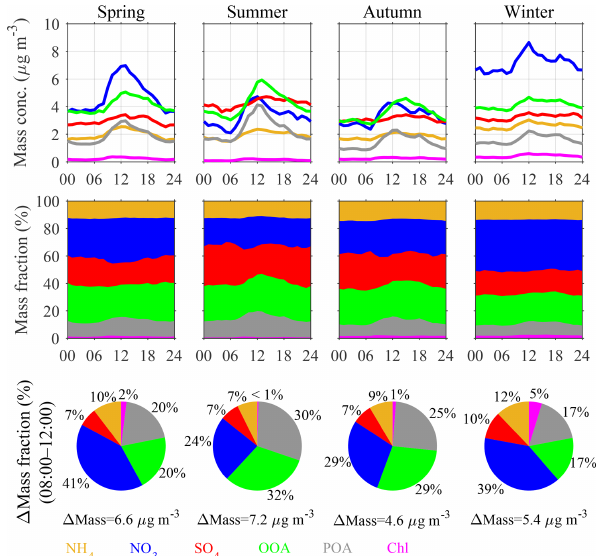
Figure 11. Diurnal variations of NR-PM 1 mass concentration (µgm − 3 ) (upper panel) and mass fraction (%) (middle panel) at SHT in four seasons. Mass fractions (%) of increased NR-PM 1 dur- ing 08:00–12:00 (lower panel) in four